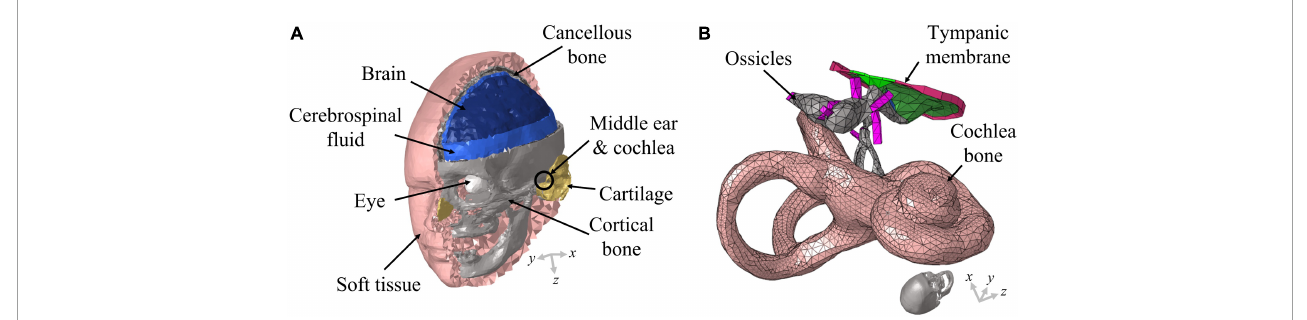
FIGURE1 Schematic of the full-head model used in this study. (A) The head model consists of the brain, cerebrospinal fluid, eyes, soft tissue, cortical bone, cartilage, and cancellous bone; (B) the auditory periphery model consists of the middle ear and cochlea. The auditory periphery model is located in an appropriate position within the head model. The ends of the ligaments and the outer cochlear bone are connected with the skull in the head model.